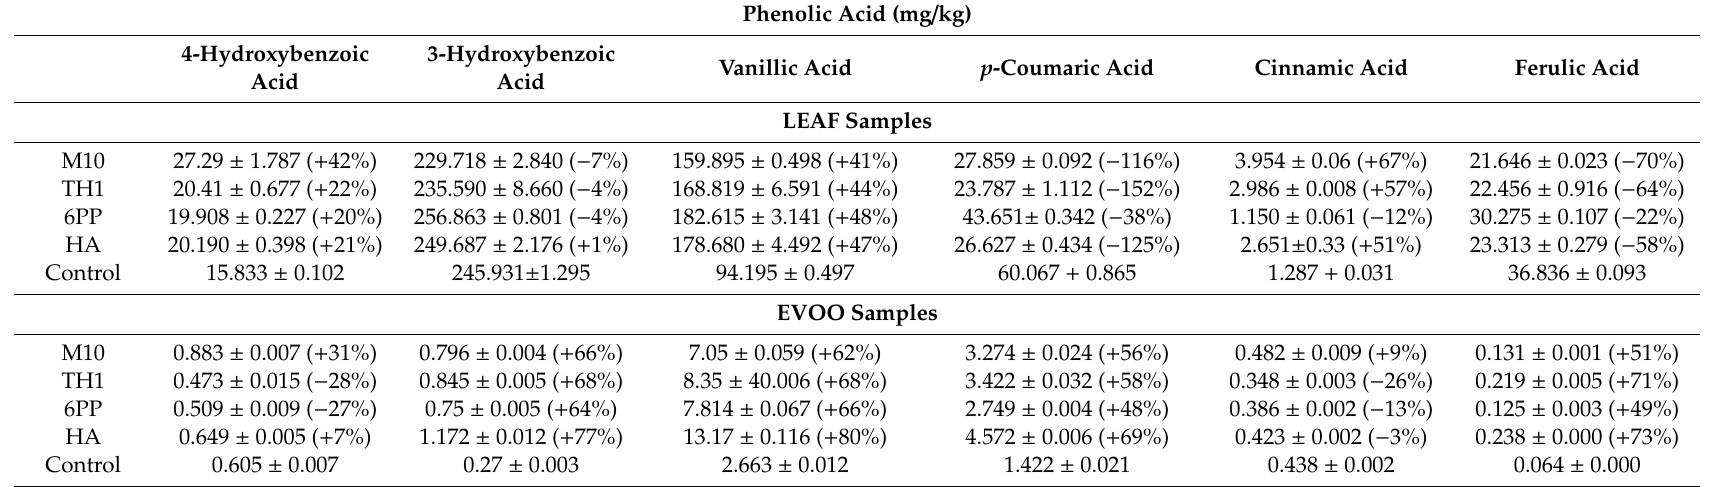
Table 5. Phenolic acids in the leaf and the EVOO samples.